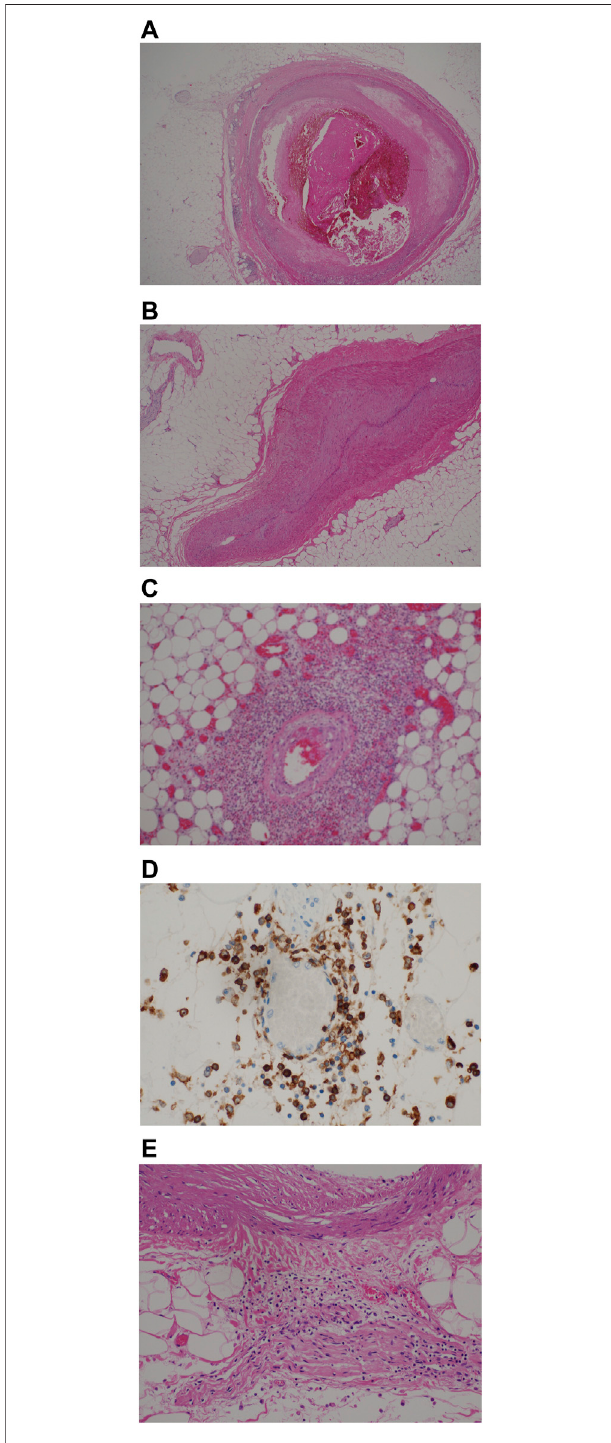
FIGURE 1 | (A) Coronary vessel with fresh fi brin thrombus, moderate in fl ammation,mild fi brosis(H&E,x200). (B) appositionofvascularendothelium (H&E, x200). (C) Perivascular in fl ammation around epicardial vessel (H&E, x200). (D) CD4-positive T-cells in perivascular tissue, 200x. (E) Perivascularin fl ammationextendingtoadiposetissueandinvolvingperipheral nerve (H&E,